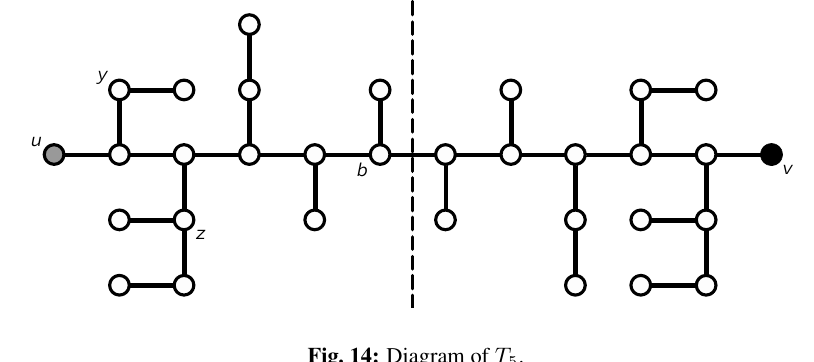
Fig. 14: Diagram of T 5